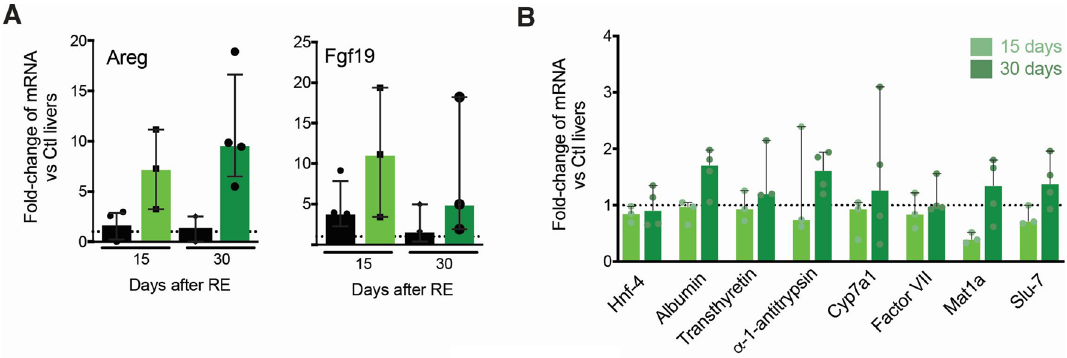
Figure 6. Gene expression. ( A ) Gene expression of regenerative cytokines in the CrLs in sham (black bar) and 0.3 GBq group (green bar) as compared with controls (dot line). ( B ) Gene expression of hepatocyte-specific proteins in the CrLs in 0.3 GBq group (green bar) as compared with controls (dot line).